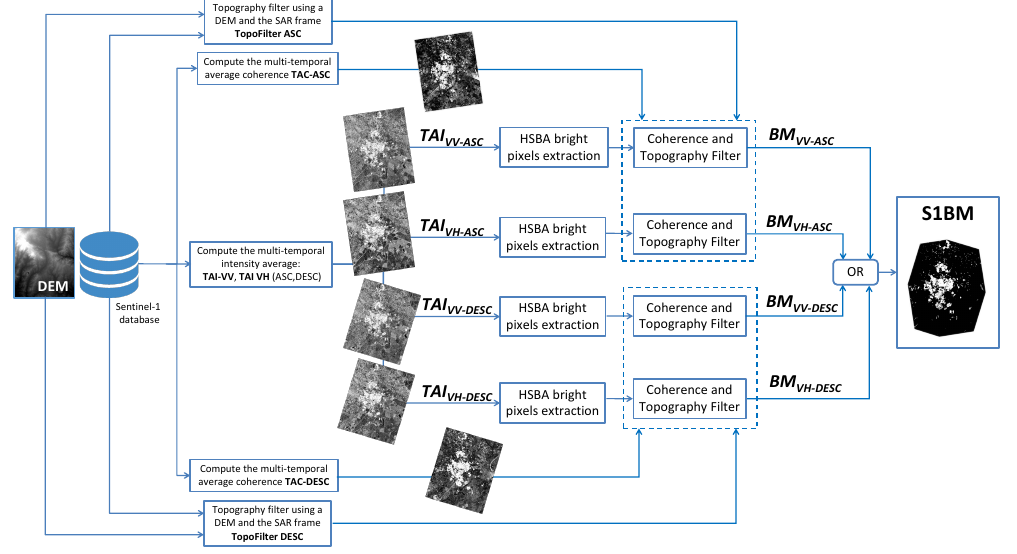
Figure 1. Block diagram of the algorithm that performs the building extraction from multi-temporal synthetic aperture radar (SAR) intensity and InSAR coherence stacks extracted from Sentinel-1